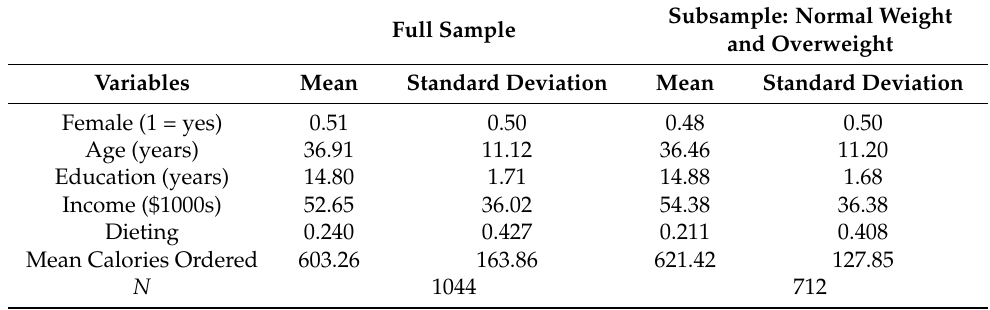
Table 2. Demographic and diet-related information.